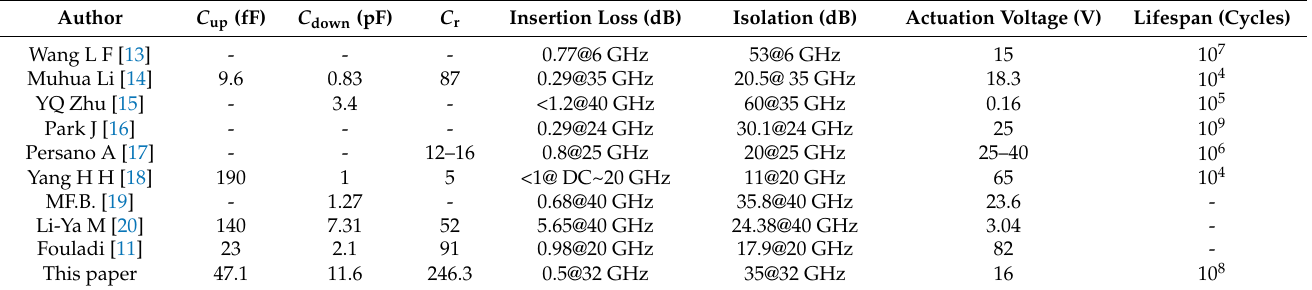
Table 2. Comparison of developed capacitive RF-MEMS